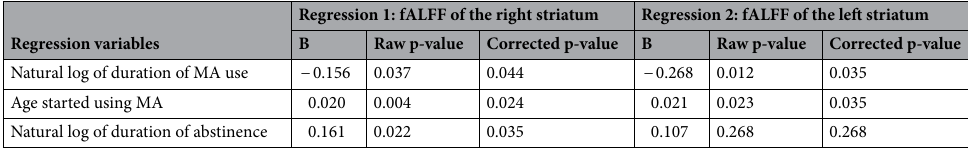
Regression 1: fALFF of the right striatum Regression 2: fALFF of the left striatum Regression variables B Raw p-value Corrected p-value B Raw p-value Corrected